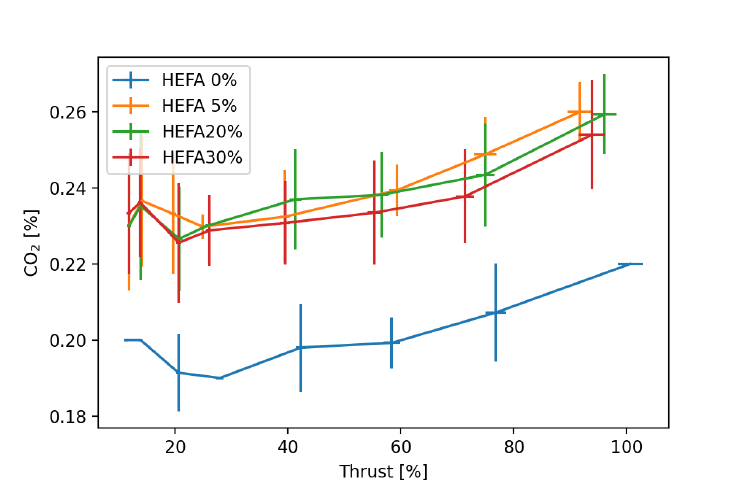
Figure 32. DGEN 380/HEFA: CO 2 .